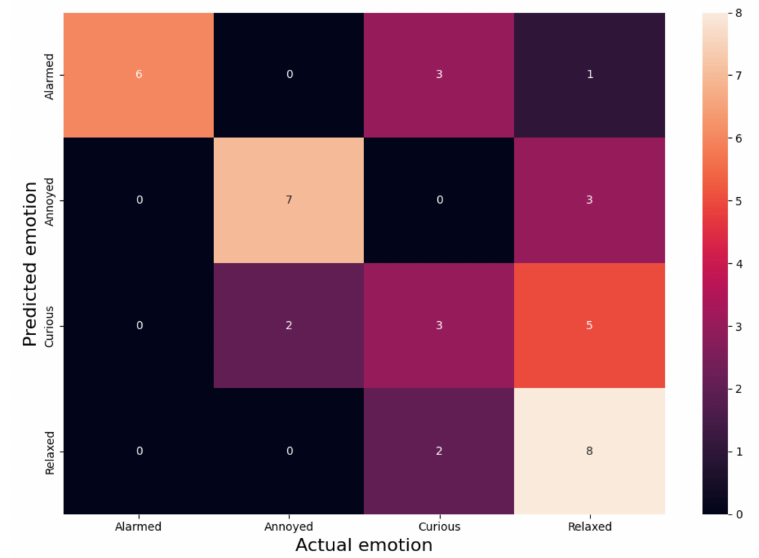
Figure 9. Confusion matrix of the final